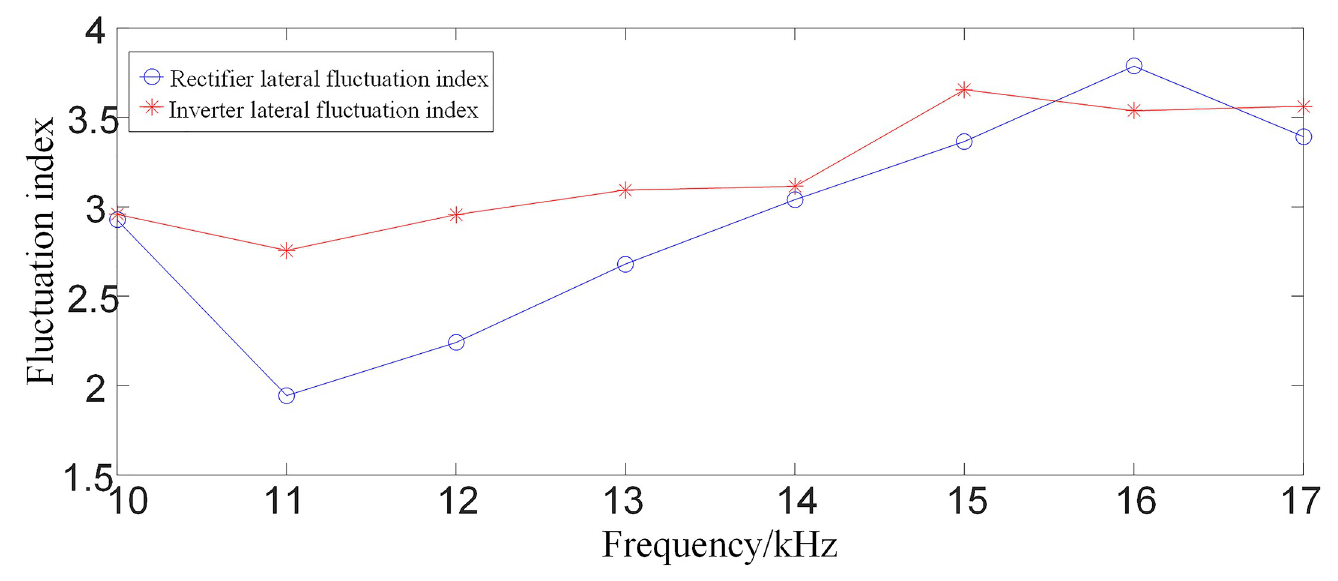
Fig 7. Multi-scale S transform fluctuation index for external